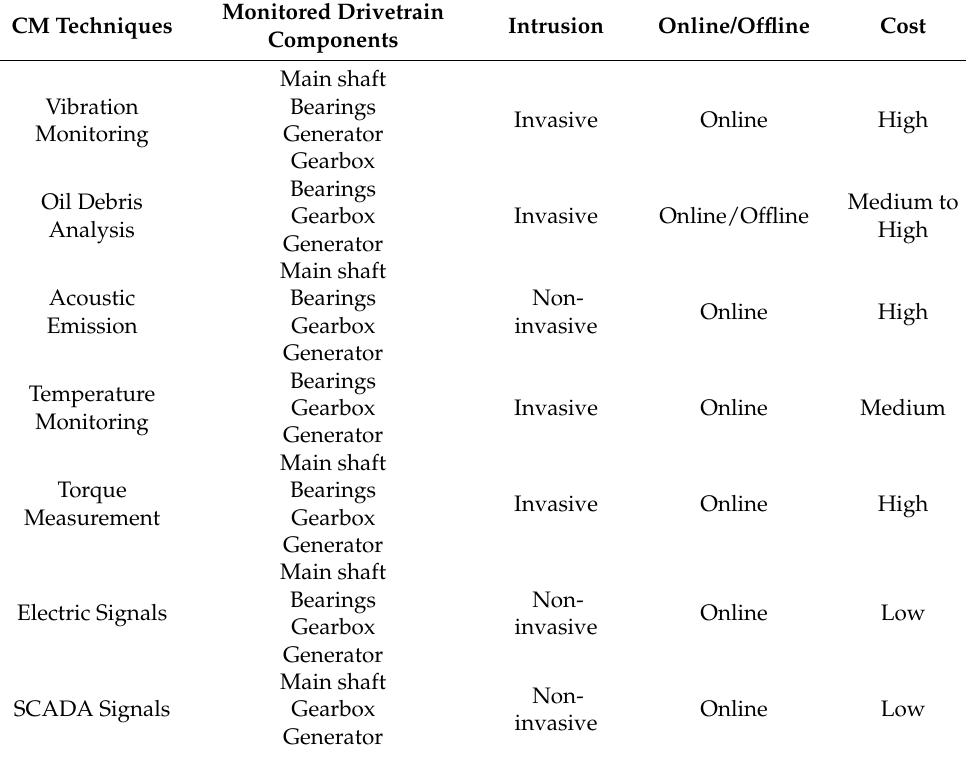
Table 1. Conventional CM systems used in the WT drivetrain. Reproduced from [23], IEEE; from [33], Durham University and from [61],